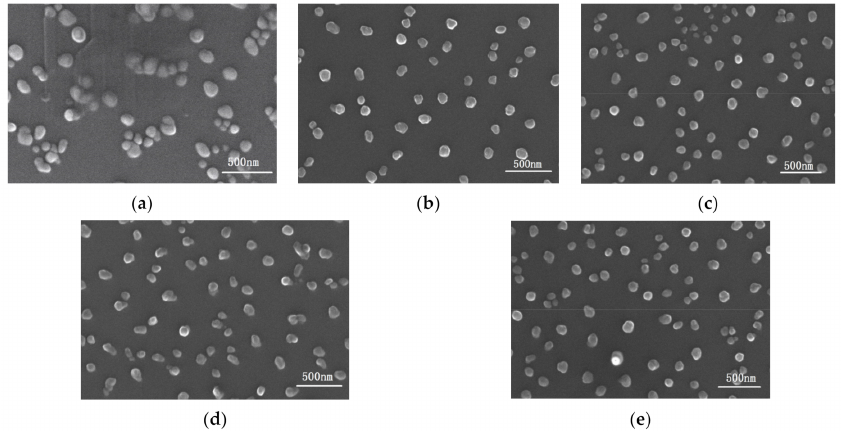
Figure 3. SEM images of the thin films deposited at 25 ◦ C for 60 min with different power: ( a ) 65 W,